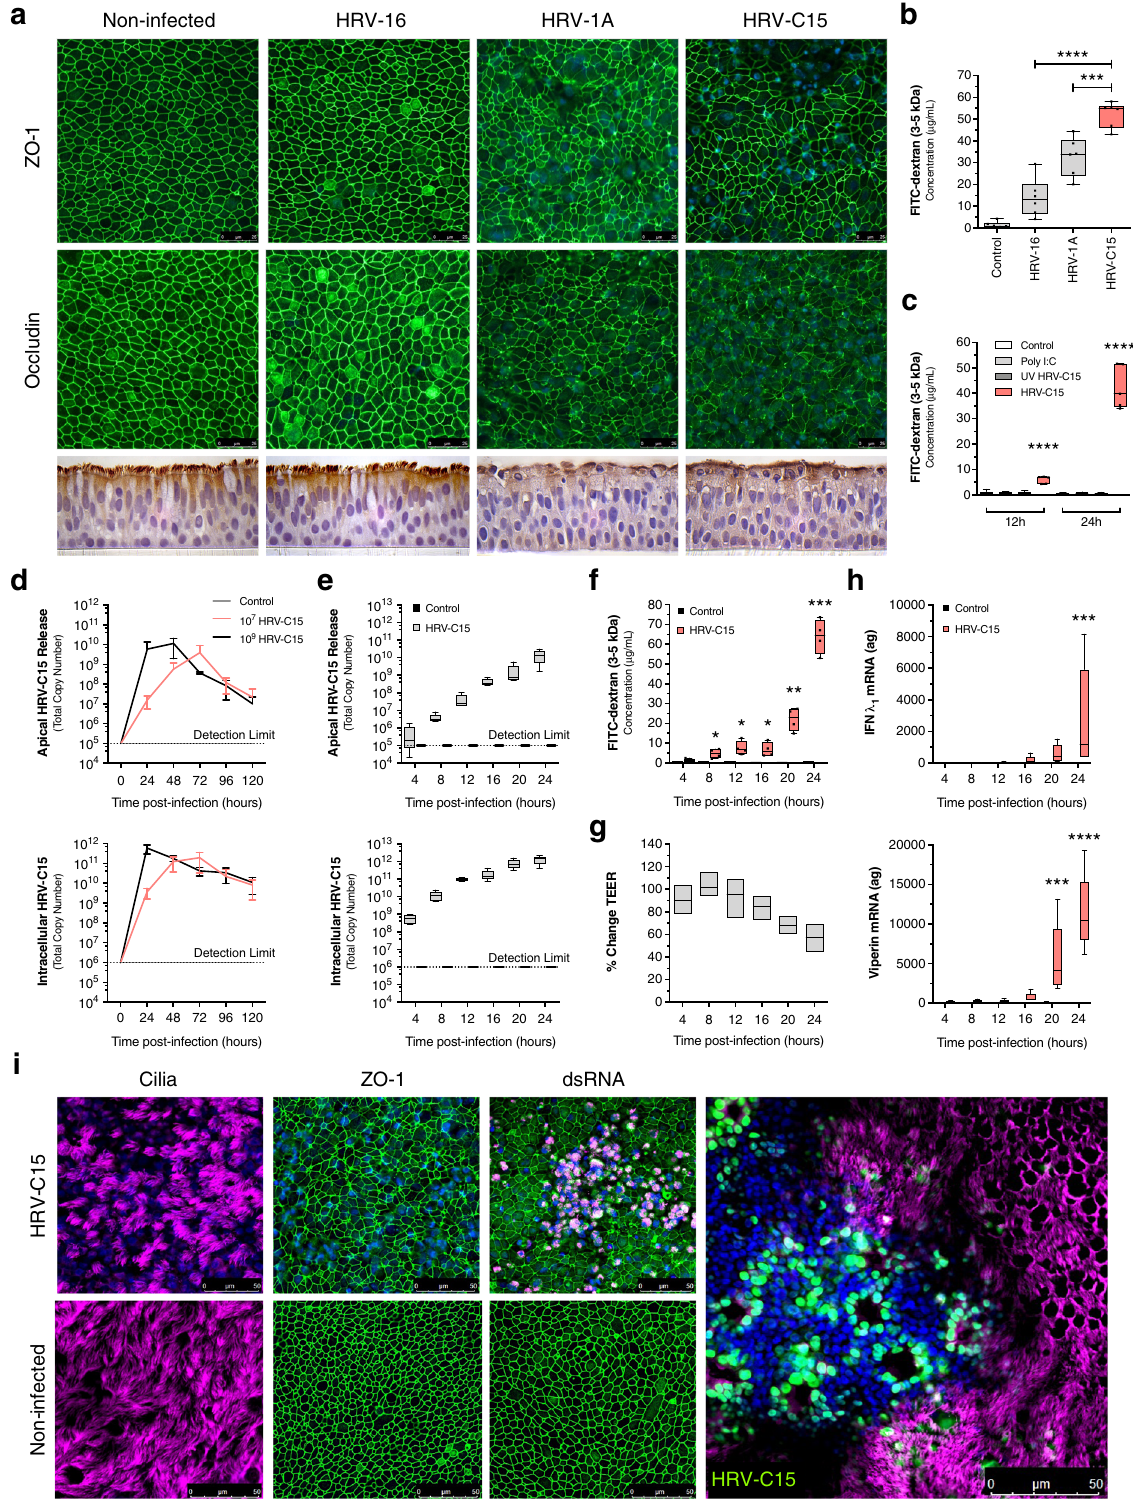
Data 1). Proteomics gene overlap analysis indicated that that the responses to HRV at 4 h may be re fl ective of generalized as time progresses to virus-speci fi c responses as the infection